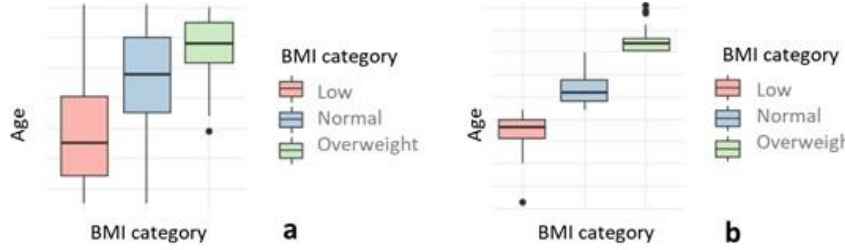
Figure 1. Box plot of age ( a ), and BMI ( b ), according to BMI category.